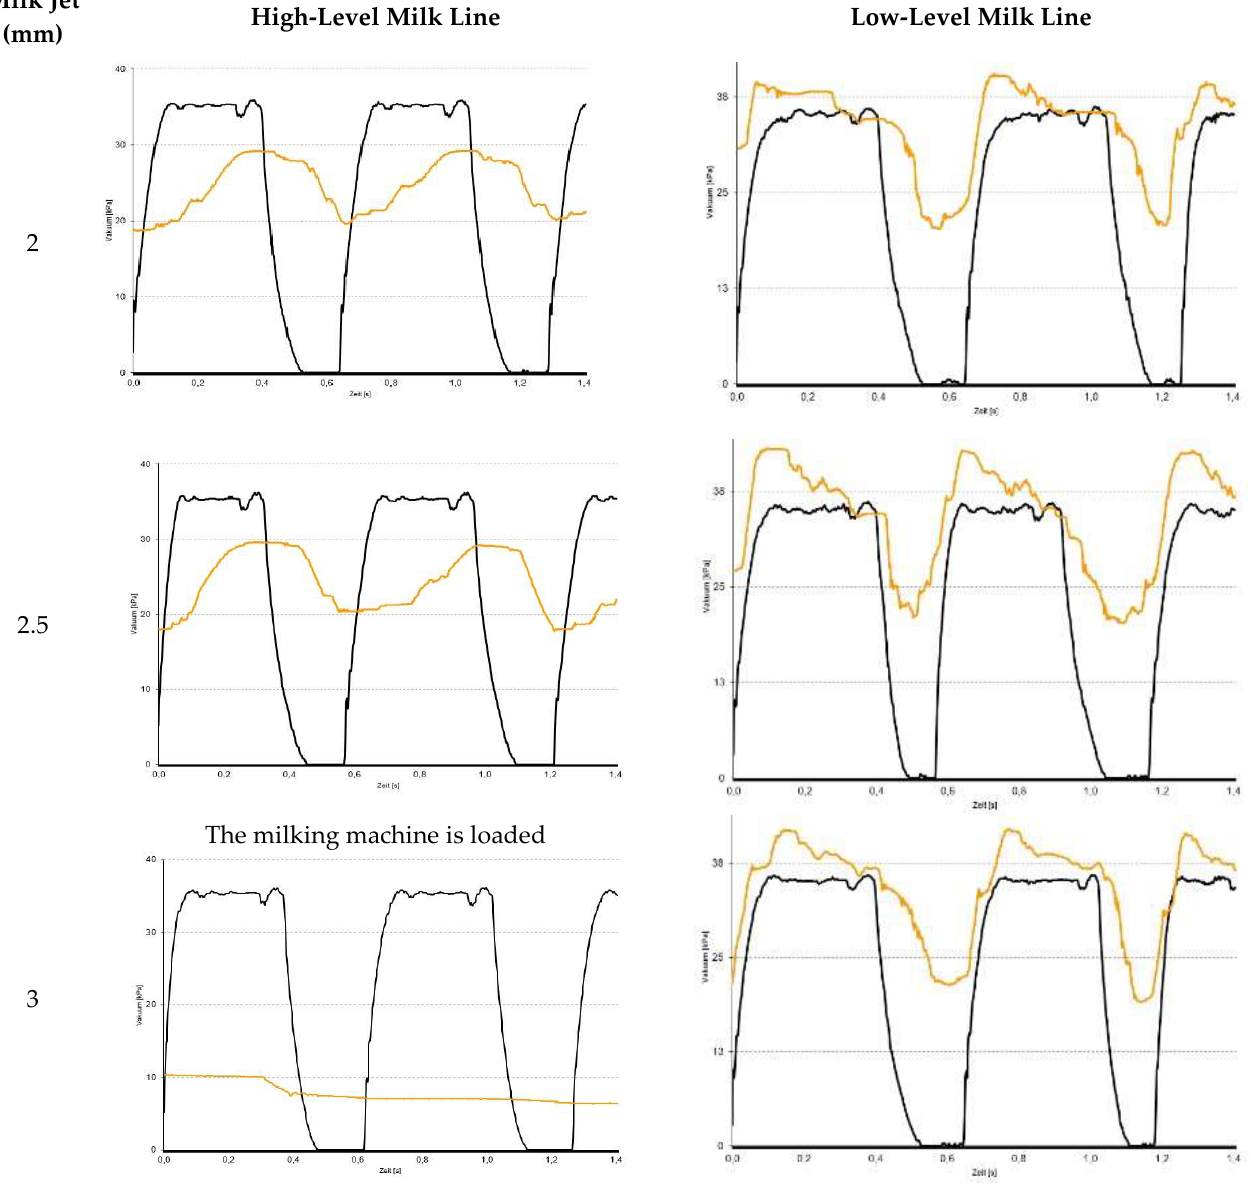
Figure 6. Cyclical vacuum fluctuations in the pulsation and inner chambers of the teat cup during the 1st WF in the goat milking machine, with the following settings: 36 vacuum level (kPa), 90 pulsation rate (cycles/min) and 60:40 pulsation